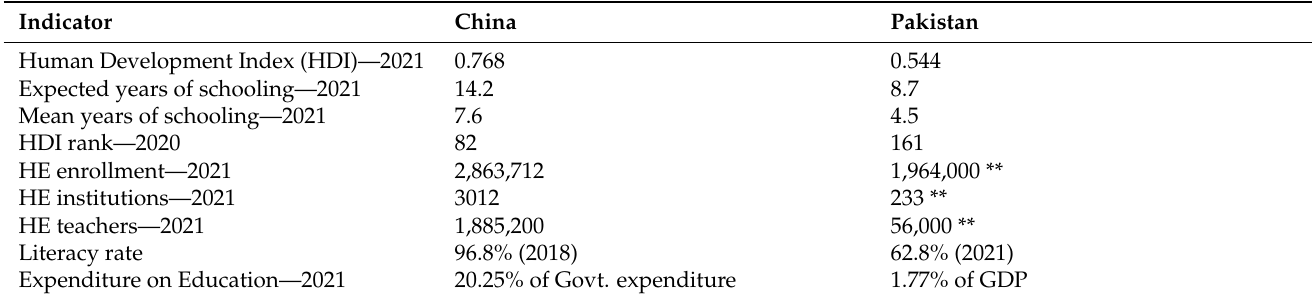
Table 2. Education Indicators; Comparison of China and Pakistan Human Development Report